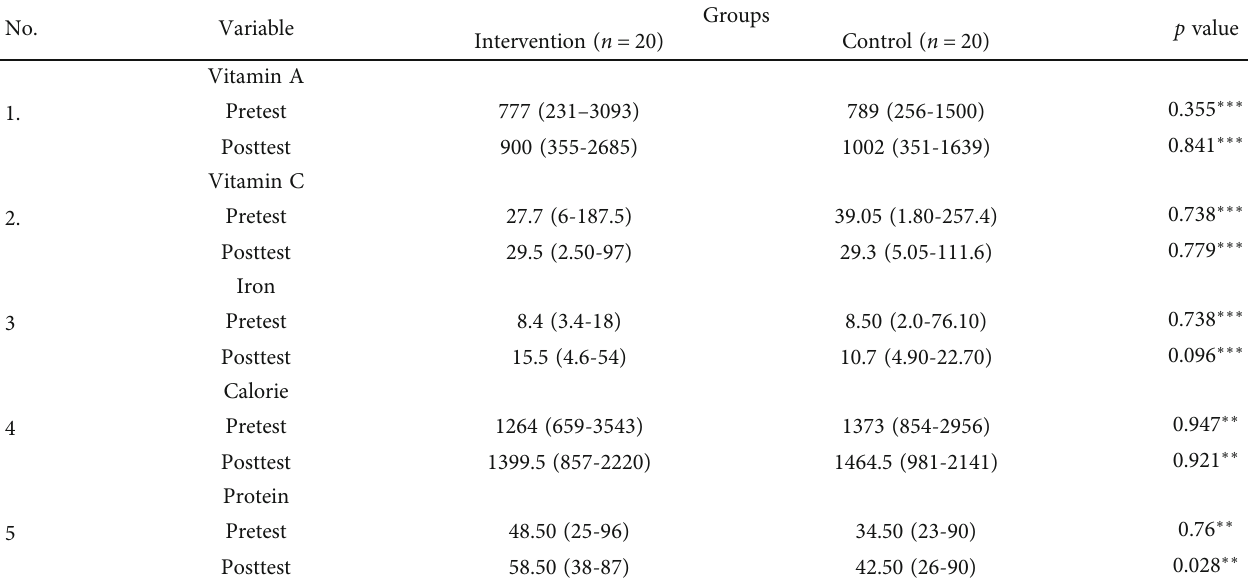
Table 4: Vitamin A, protein, iron, vitamin C, calorie, and energy intake in both groups. No.